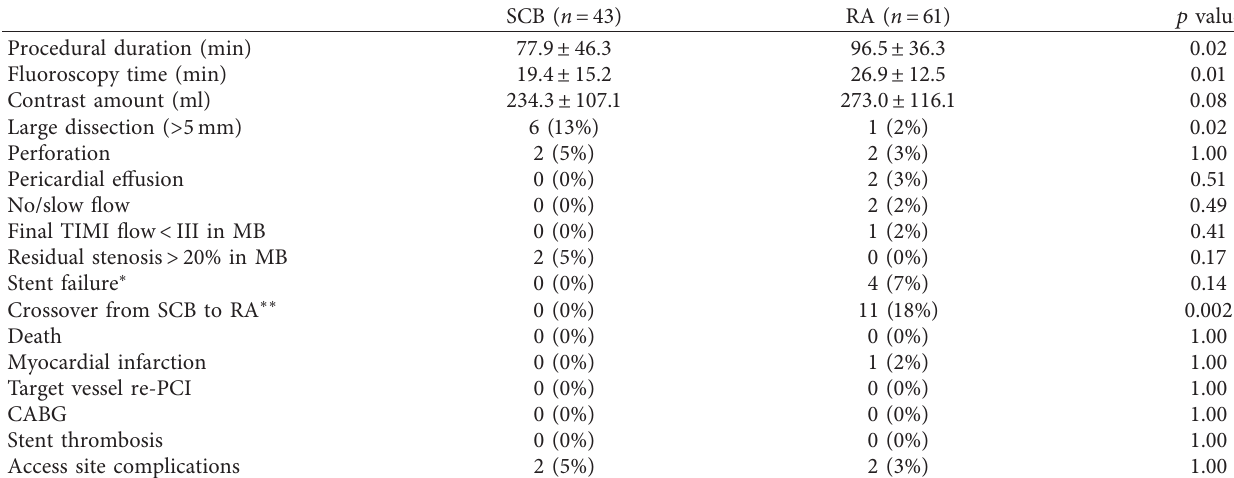
Table 3: Procedural and in-hospital outcome ( n � 104 patients).